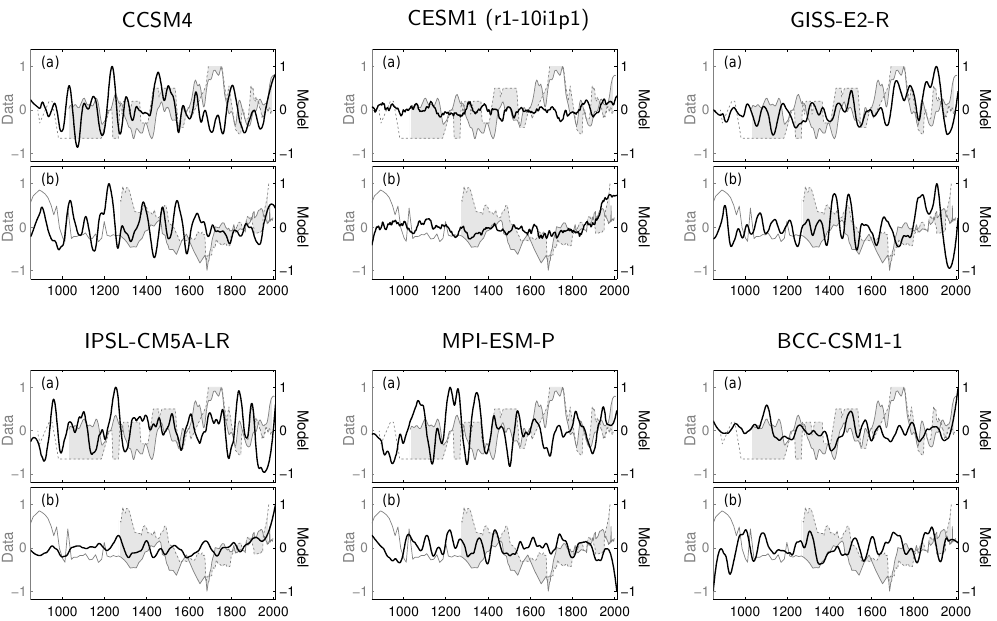
Figure 7. Comparison between last-millennium time series of the reconstructions (in grey) and of P - E simulated by six GCMs (in black) averaged over the Challa–Naivasha region (a) , with the Naivasha record shown as dashed line and the Challa record as solid line; and over the Masoko–Malawi region (b) , with the Malawi record shown as dashed line and the Masoko record as solid line. In both regions, the area between the two records is shaded in light grey. Both proxy-based and simulated time series are presented as anomalies with respect to the whole period, and are linearly standardised so that the absolute maximum equals 1. Ordinate axes are oriented such that wetter (drier) conditions point upwards (downwards). Model time series are annual mean values filtered using a loess method with a window of 100 years. For the CESM1 model, the black curve is the median of the 10 ensemble members previously standardised and smoothed.